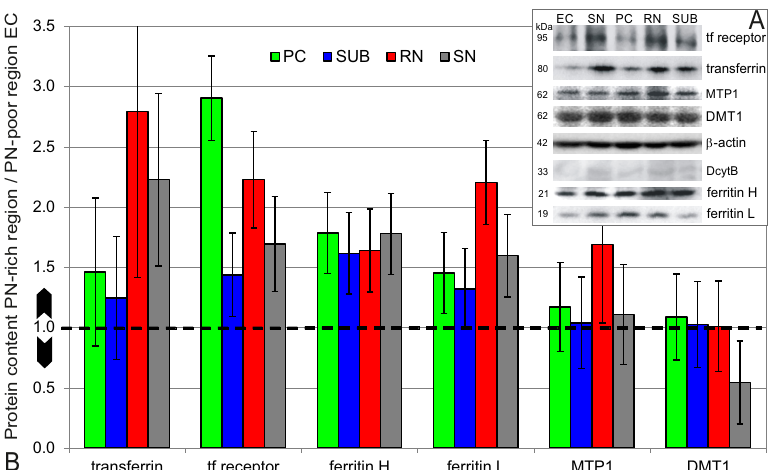
Figure 8. Western blot. ( A ) Iron protein specific antibodies were verified by the molecular weights (kDa) of the target proteins. The DcytB specific antibody showed an insufficient signal which impeded WB analysis. ( B ) Relative quantities of proteins from PN-rich brain regions (PC, SUB, RN, SN) with respect to protein content in the PN-poor region (EC). The dotted line marks the base level ratio of one, i.e., no difference in protein expression. Data given as mean ± 95% confidence